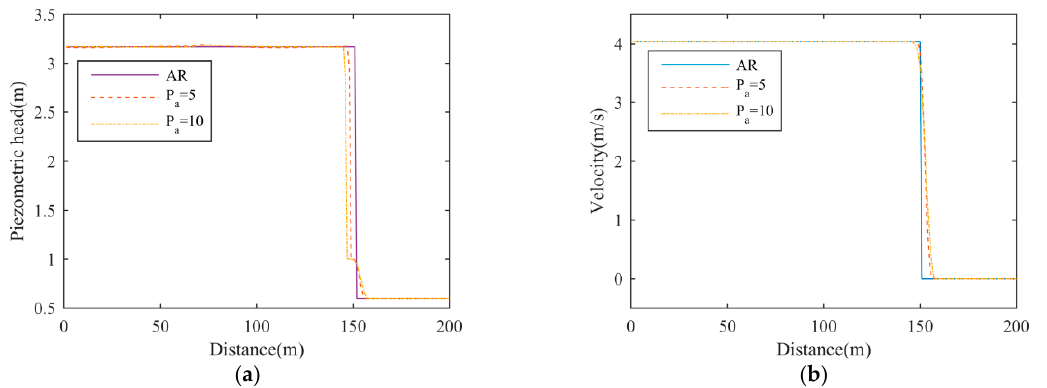
Figure 13. Comparison of the results simulated by P_HLL, with P b = 0.7 and P a = 5 or P a = 10, and the analytical result (AR): ( a ) piezometric head; ( b ) flow velocity.